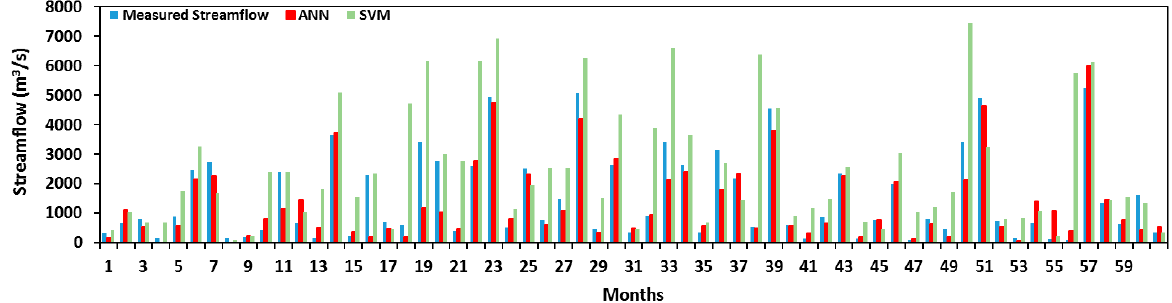
Figure 12. Comparison of streamflow forecasting results using the ANN and SVM models with the measured streamflow for the last five years of the testing period based on CHIRPS data.